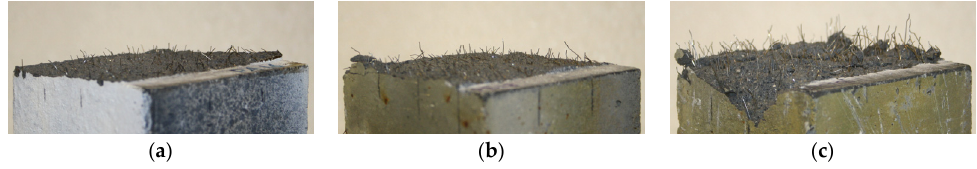
Figure 4. Morphology of fracture surface of different concretes at loading rate 2.66 × 10 3 mm/s. ( a ) Concrete PA; ( b ) Concrete PB; ( c ) Concrete PC.